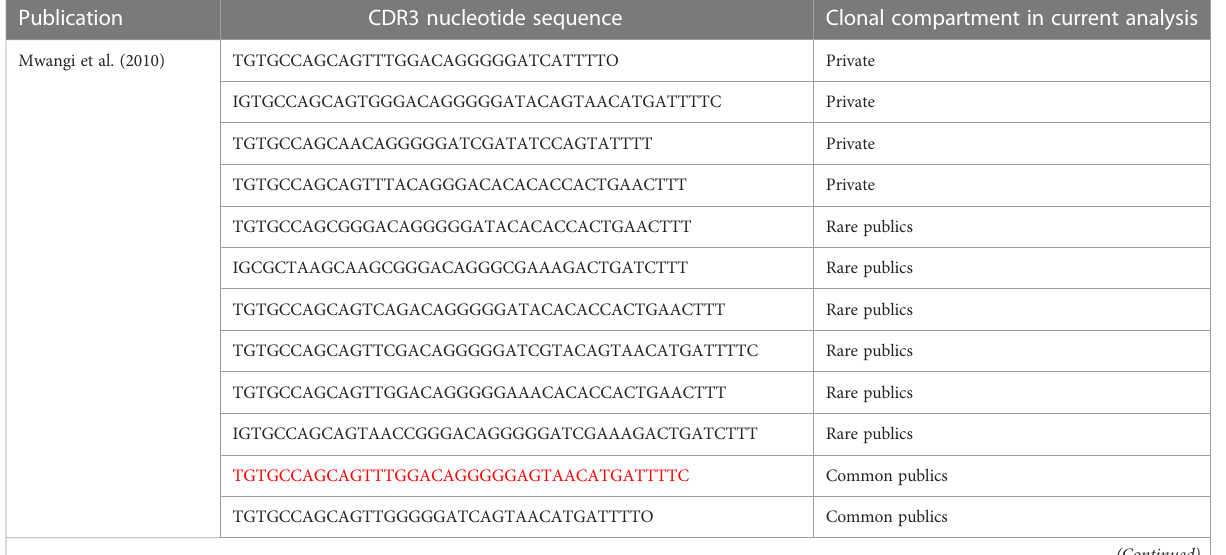
TABLE 1 TCR b CDR3 nucleotide sequences shared with other published works. CDR3 nucleotide sequence Clonal compartment in current analysis Mwangi et al.